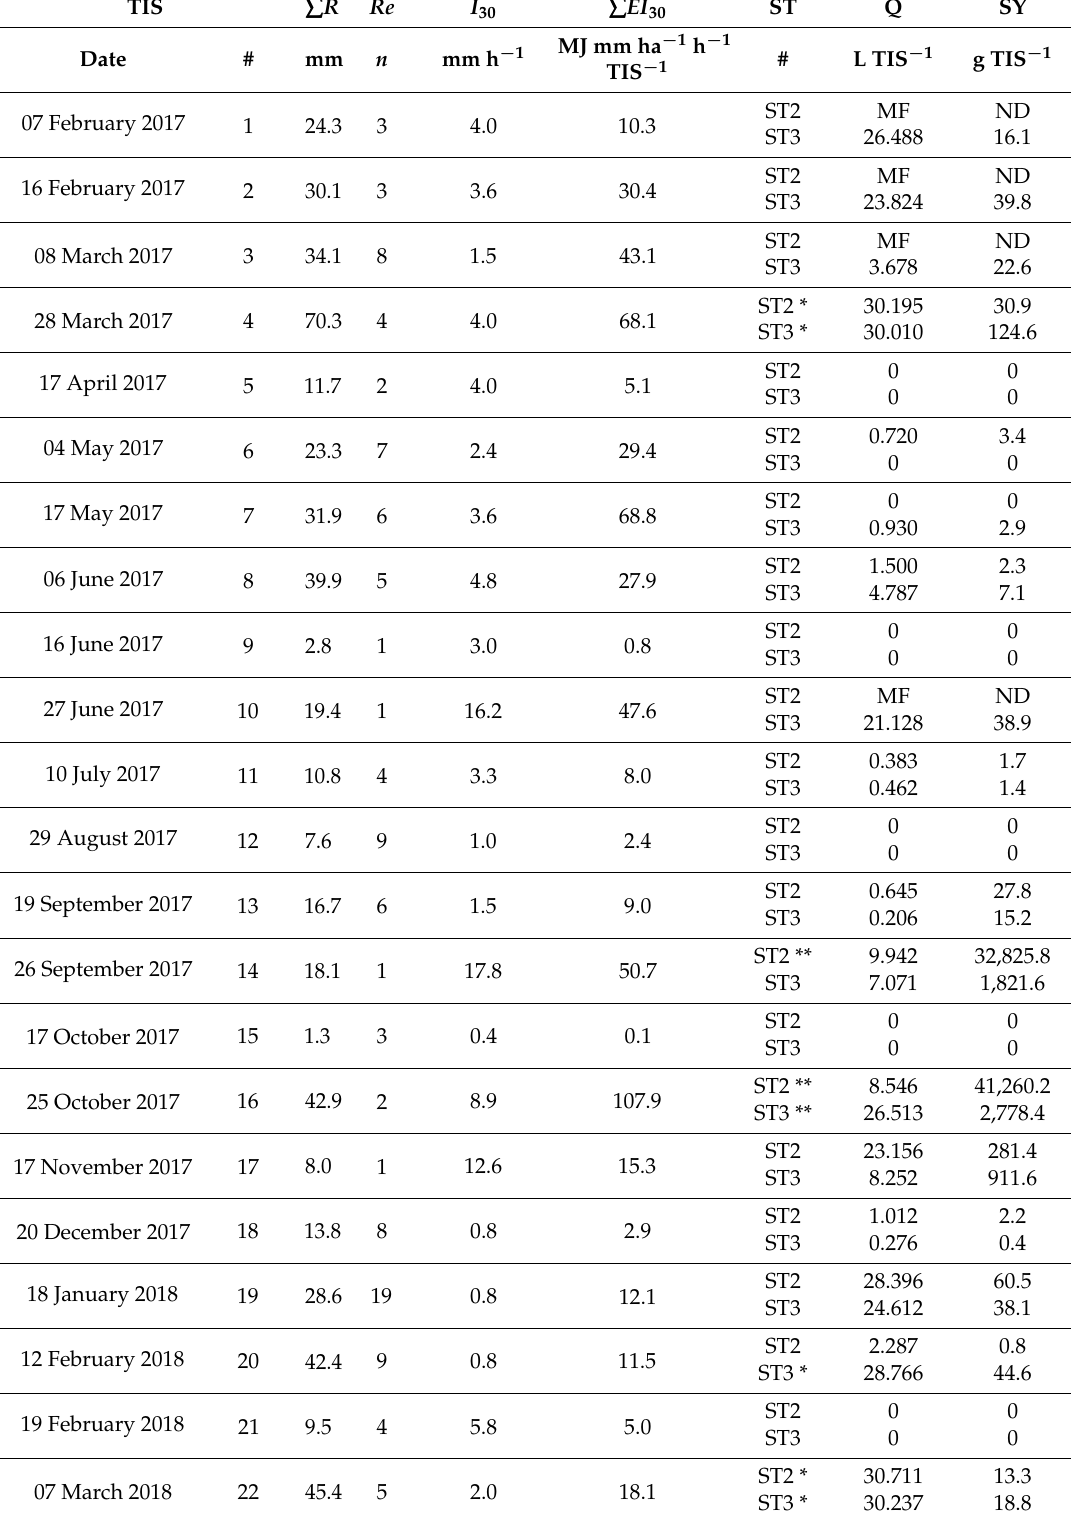
Table 5. Accumulated rainfall depth ( ∑ R ) and erosivity ( ∑ EI 30 ), number of rainfall events ( Re ) and mean rainfall intensity ( I 30 ) calculated with the synthetic weather station and runoff ( Q ) and sediment ( SY ) yields observed in the two sediment traps (ST) at each time-integrated survey (TIS) during the 15-month test